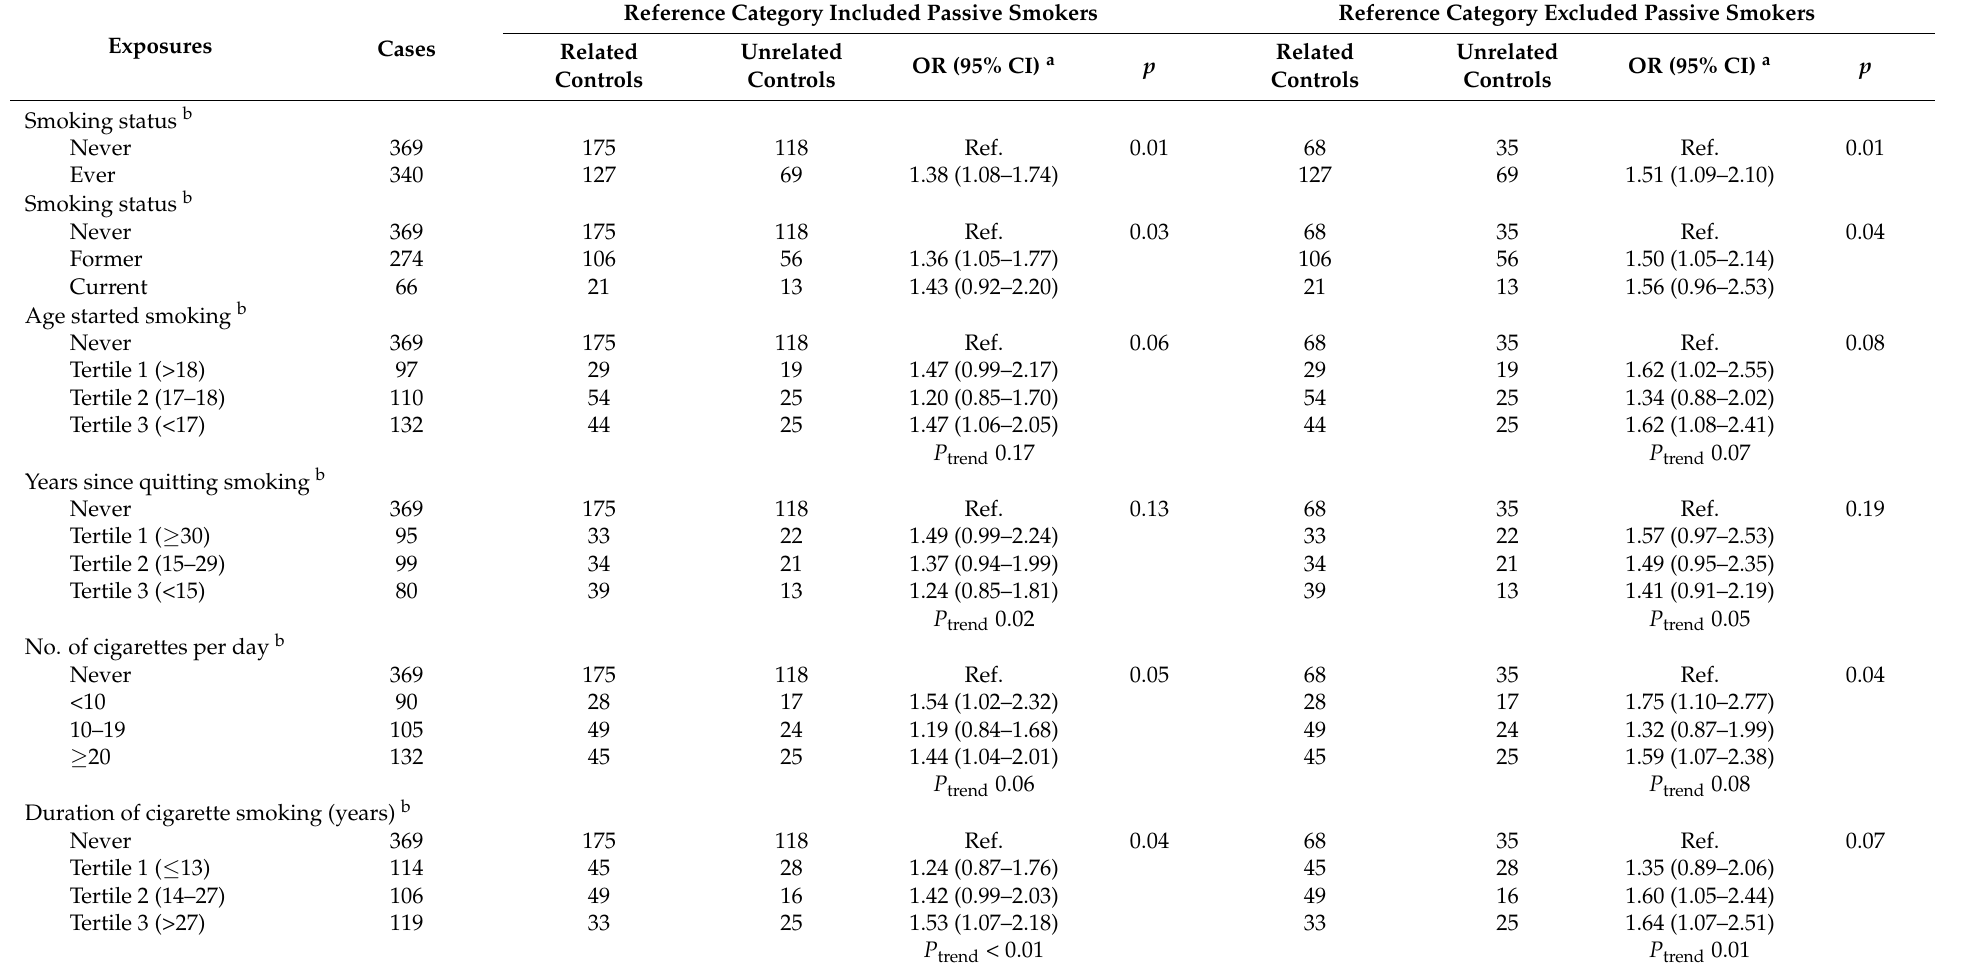
Table 2. Odds ratios and 95% confidence intervals for FL risk in relation to personal